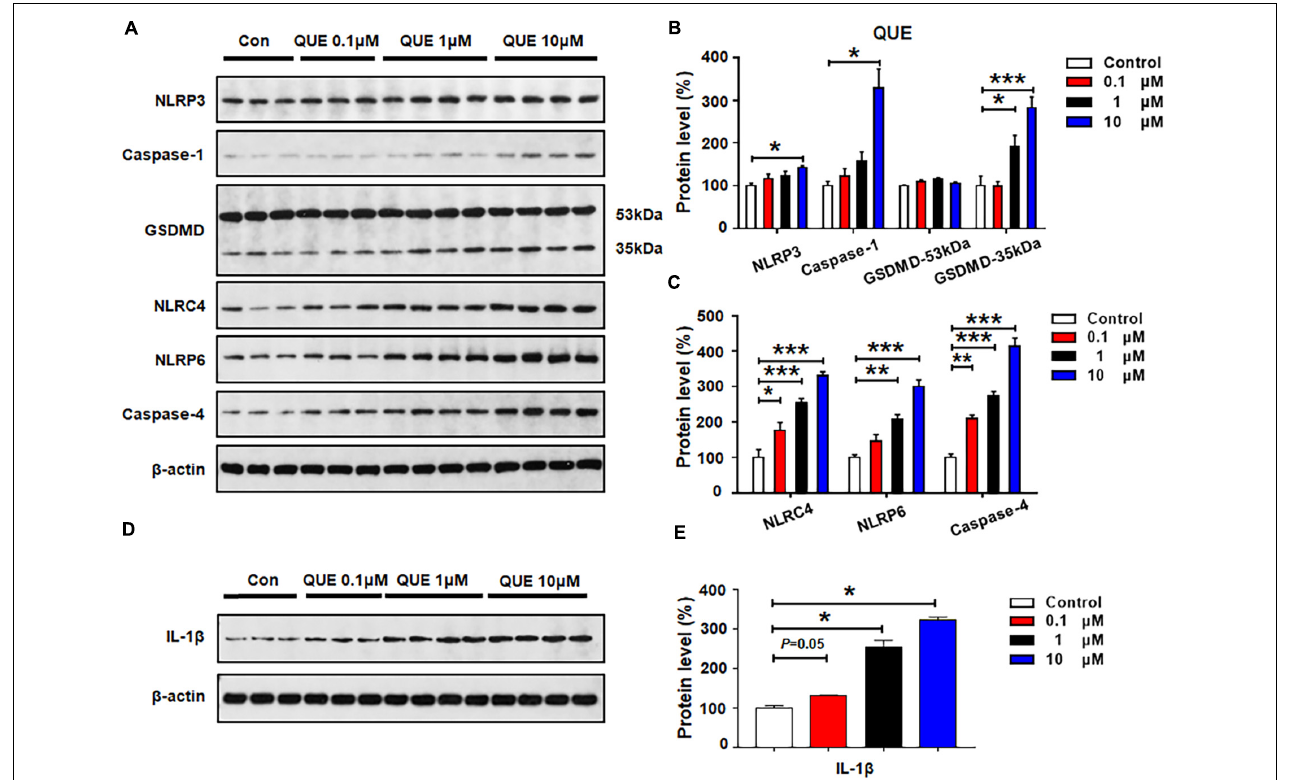
FIGURE 3 | Quetiapine treatment activated NLRP3/caspase-1 signaling and upregulated NLRC4, NLRP6, and IL-1 β protein expression in cultured astrocytes. Cells were treated with 0.1, 1, or 10 µ M quetiapine for 24 h. (A–E) Western blot was used to examine the expression of NLRP3, caspase-1 (20 kDa), GSDMD (53 and 35 kDa), NLRC4, NLRP6, and IL-1 β . The data are presented as the mean ± standard error of the mean. * p < 0.05, ** p < 0.01, *** p < 0.001 vs. control (one-way analysis of variance and post hoc Dunnett’s multiple comparison test; n = 3–4 cultures/western blot group). Con, control; QUE, quetiapine.